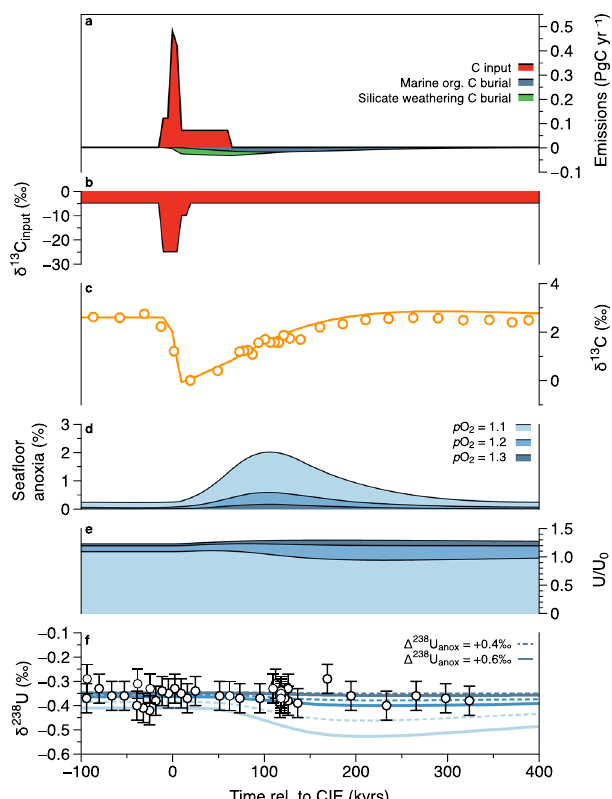
Fig. 3 Model simulations of anoxia for PETM perturbation. Results plotted as a function of time relative to the onset of the carbon isotope excursion (CIE); a model forcing carbon input and calculated removal rates due to silicate weathering and marine organic carbon burial. b δ 13 C composition of carbon input. c Model δ 13 C (orange solid line) compared to smoothed and normalized planktonic foraminifera data (orange symbols) from Site 401 (ref. 1 ). d Sea fl oor anoxia estimates for model runs with p O 2 = 1.1 – 1.3 PAL, but the same carbon emission scenario shown in a . e Calculated response of the global seawater U reservoir normalized to modern (U/U 0 ) which shows an increase at the PETM onset due to increased riverine inputs. f Model δ 238 U sw for p O 2 = 1.1 – 1.3 PAL using Δ 238 U anox = + 0.6 (solid lines) and + 0.4 ‰ (dashed lines), compared to δ 238 U CAU from Site 865 (excluding anomalously low data point). Error bars for δ 238 U CAU ( f ) represent the external reproducibility of the NIST-SRM 1d limestone standard (±0.06 ‰ ,